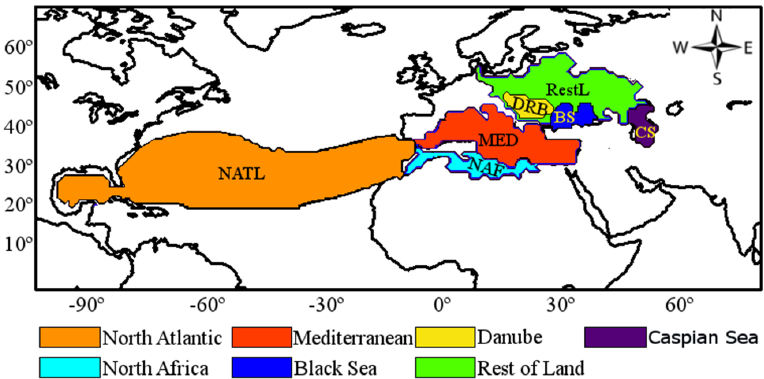
Figure 4. Schematic representation of moisture sources for the DRB identified in Figure 2.